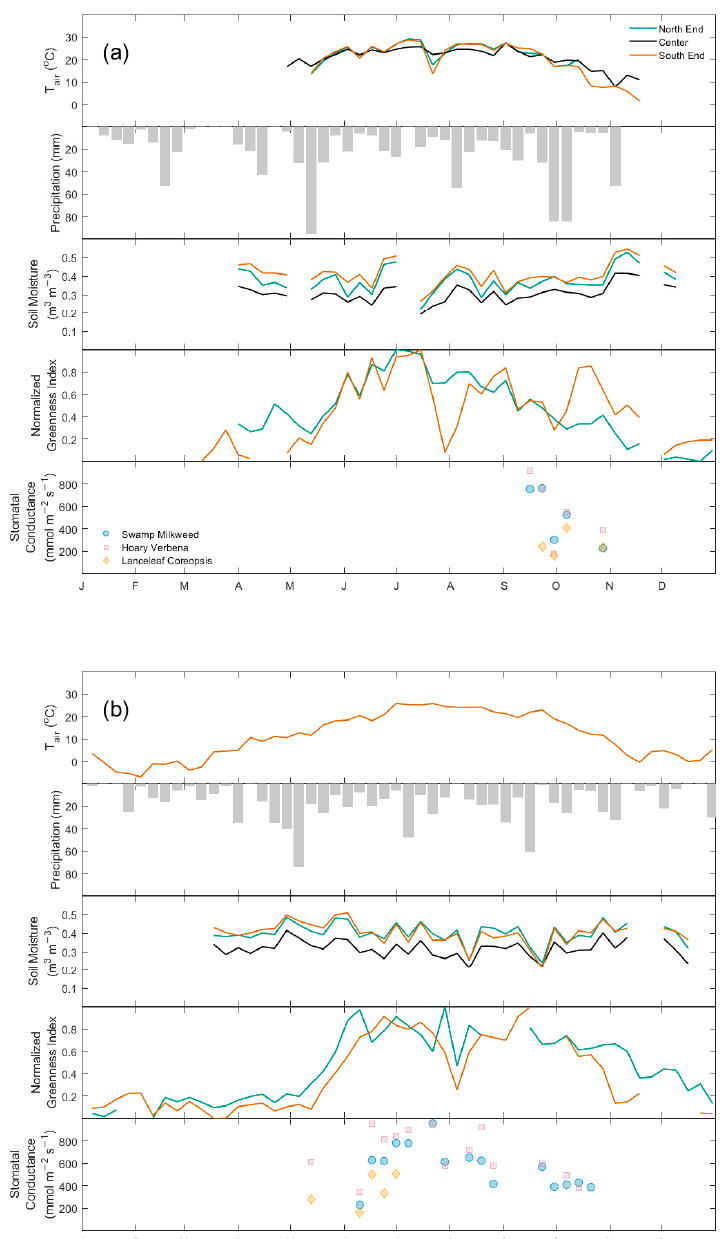
Figure 6. Weekly air temperature, precipitation, soil moisture, normalized greenness index, and stomatal conductance measurements in ( a ) 2018 and ( b ) 2019.